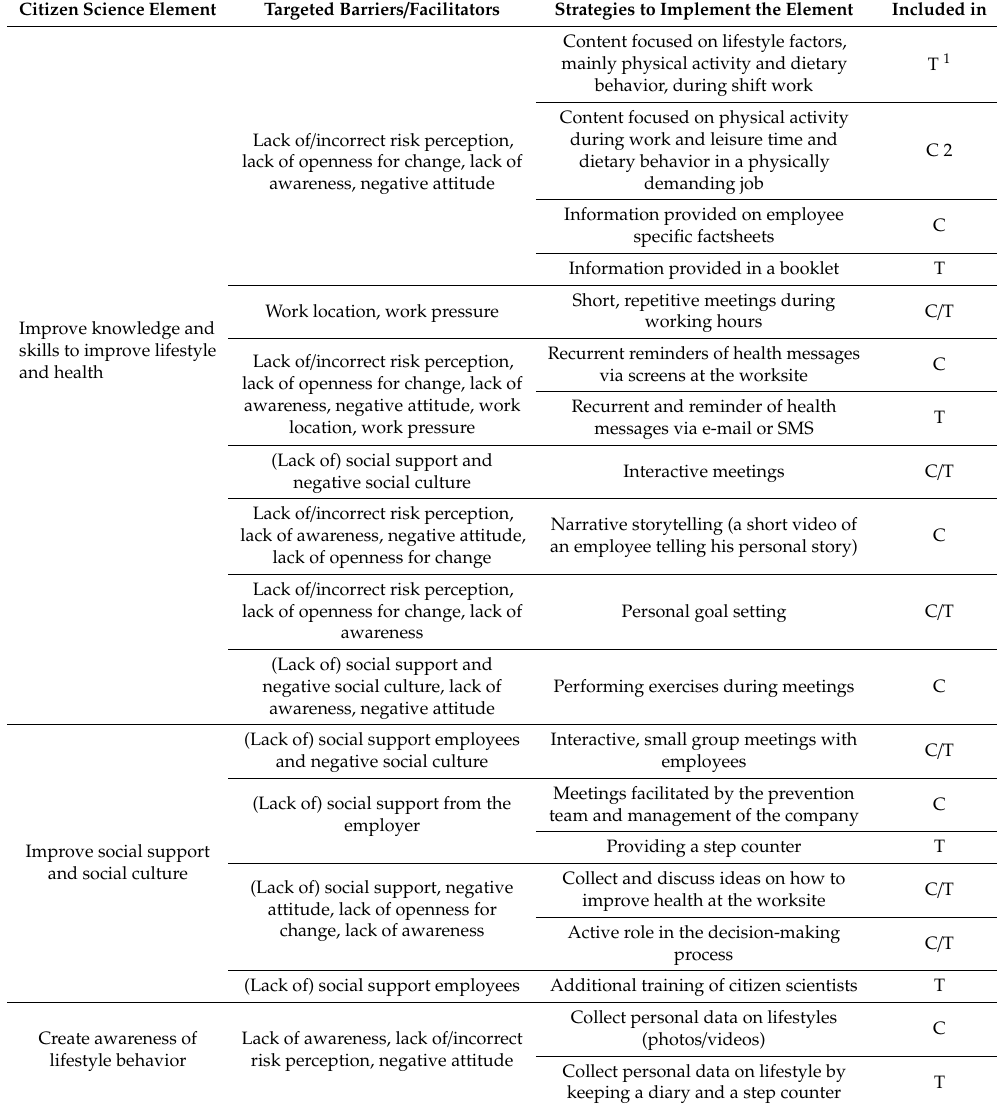
Table 2. Identified citizen science elements, strategies and targeted barriers and facilitators for citizen science to improve health in each